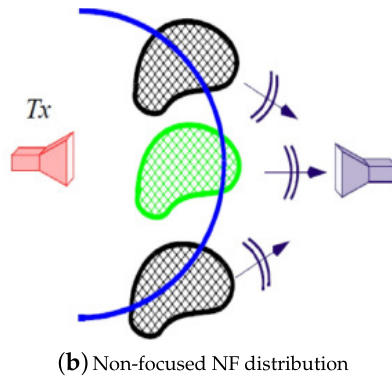
Figure 2. ( a ) represents the scenario in which a focused NF beam is used for irradiation of the OI (central green object); ( b ) represents the scenario in which a non-focused NF beam is used for irradiation. The side black objects are the undesired